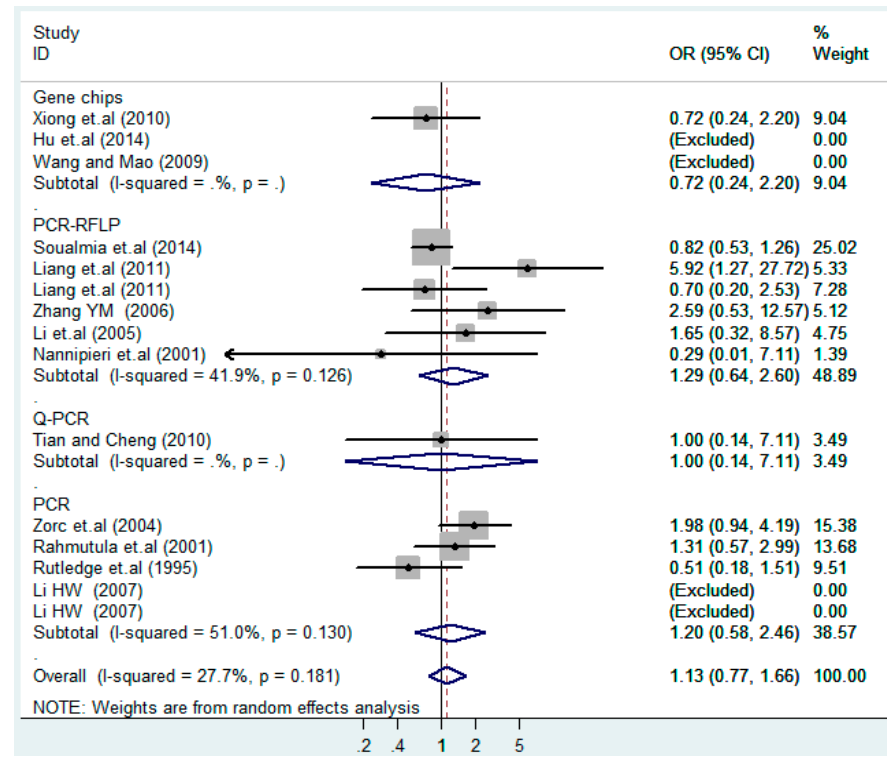
Figure 23. Subgroups of genotyping of T2238C recessive model CC vs. (TT + TC).